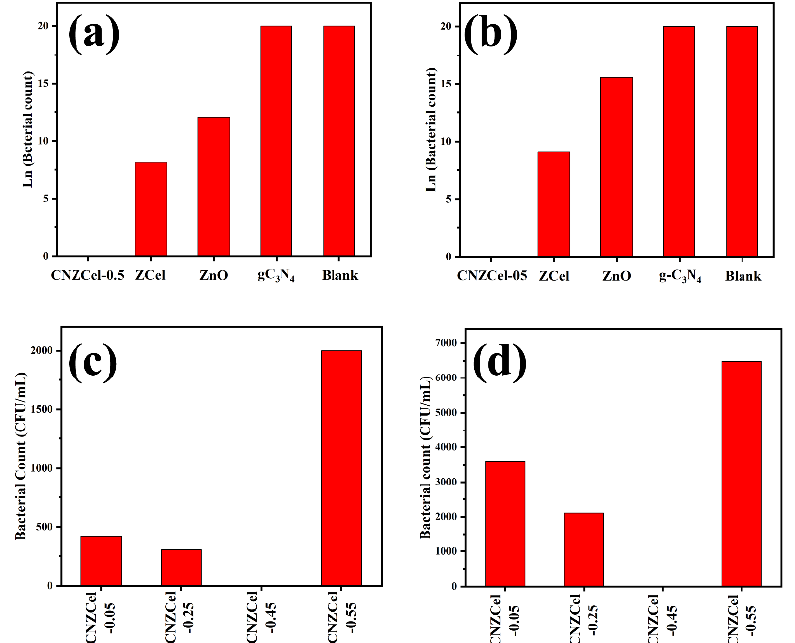
Figure 22. ( a ) Plots of bacterial counts of g-C 3 N 4 /ZnO/cellulose-0.45 (0.45 corresponds to the mass of g-C 3 N 4 addition), ZnO/cellulose, ZnO, g-C 3 N 4 , and blank sample against S. aureus and ( b ) E. coli ; ( c ) bacterial counts of g-C 3 N 4 /ZnO/cellulose composites against S. aureus and ( d ) E. coli . Reproduced from Reference [202]. oxide-based